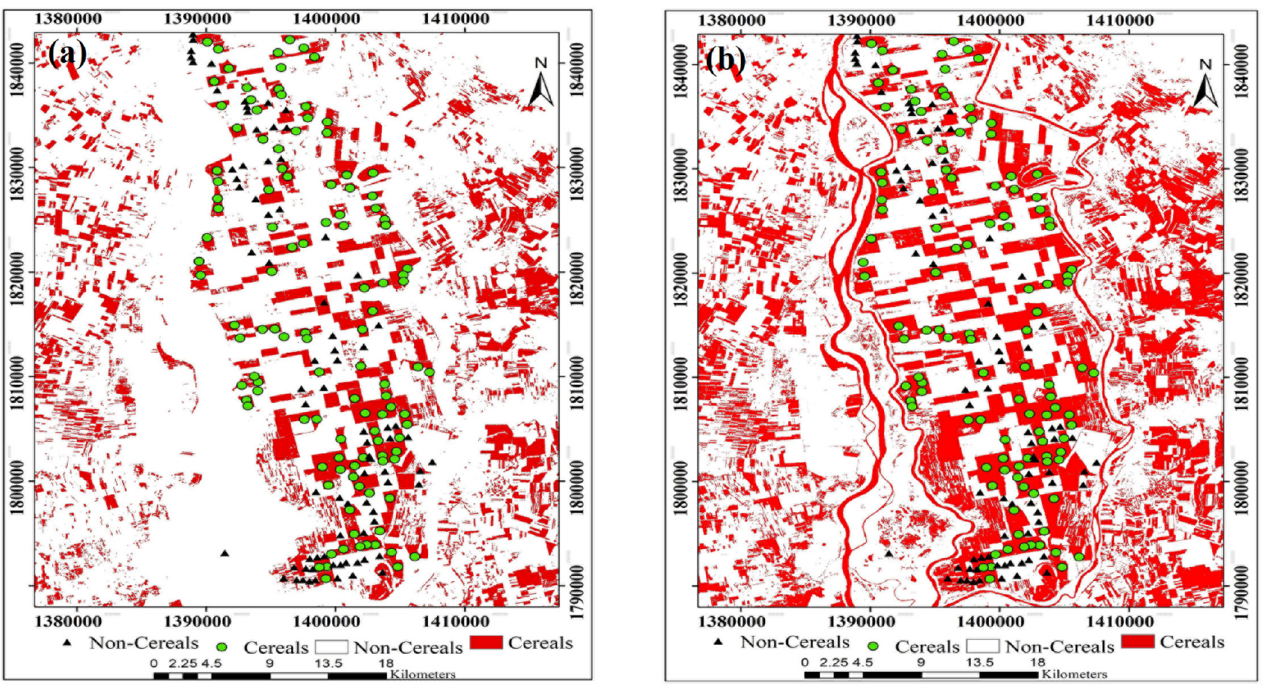
Figure 9. The comparison of the TWDTW method ( a ) and random forest method ( b ) for winter cereal classification in classification in Romania.